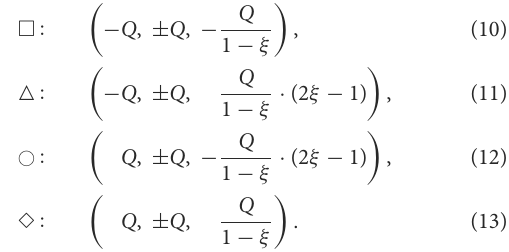
z -coordinate. The boxes B −− and B −+ in Figure 6B1, however, still